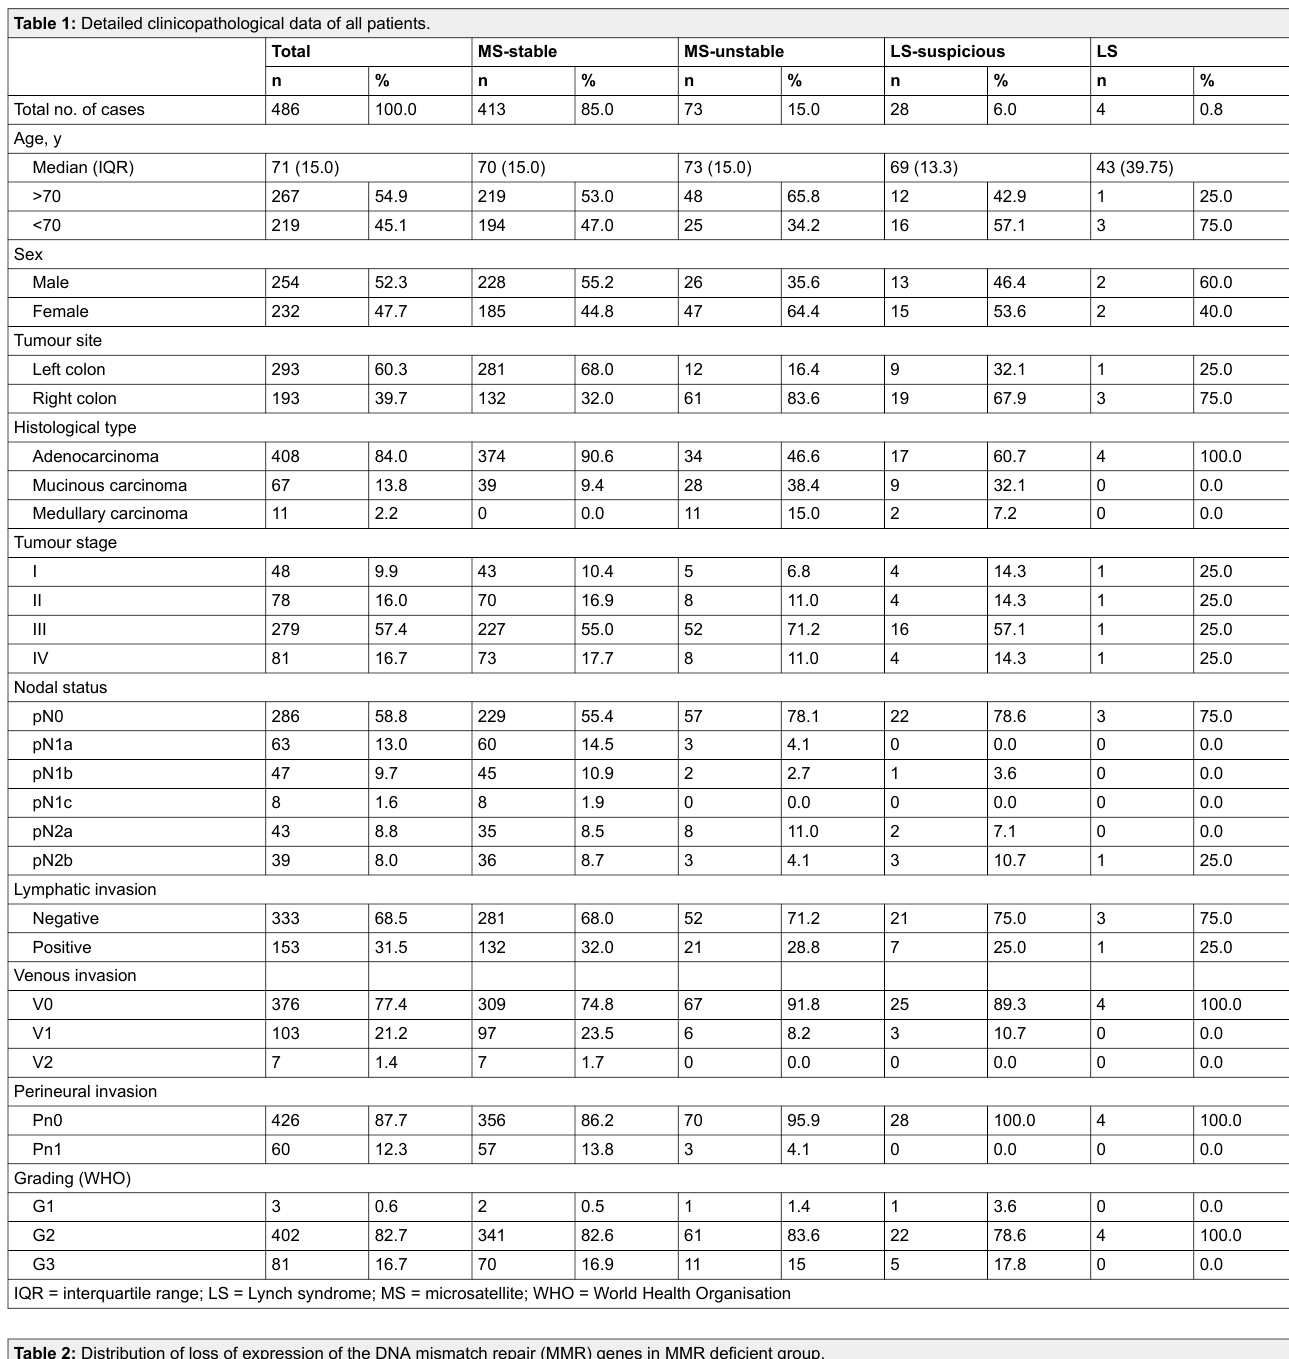
Table 1: Detailed clinicopathological data of all patients.